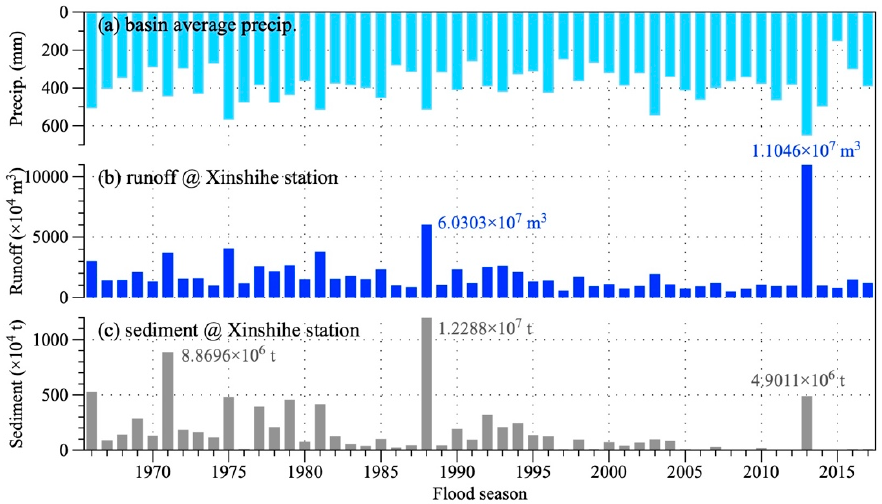
Figure 2. Time series of flood season’s rainfall and mean air temperature over the Yunyan River Basin from 1966 to 2017.